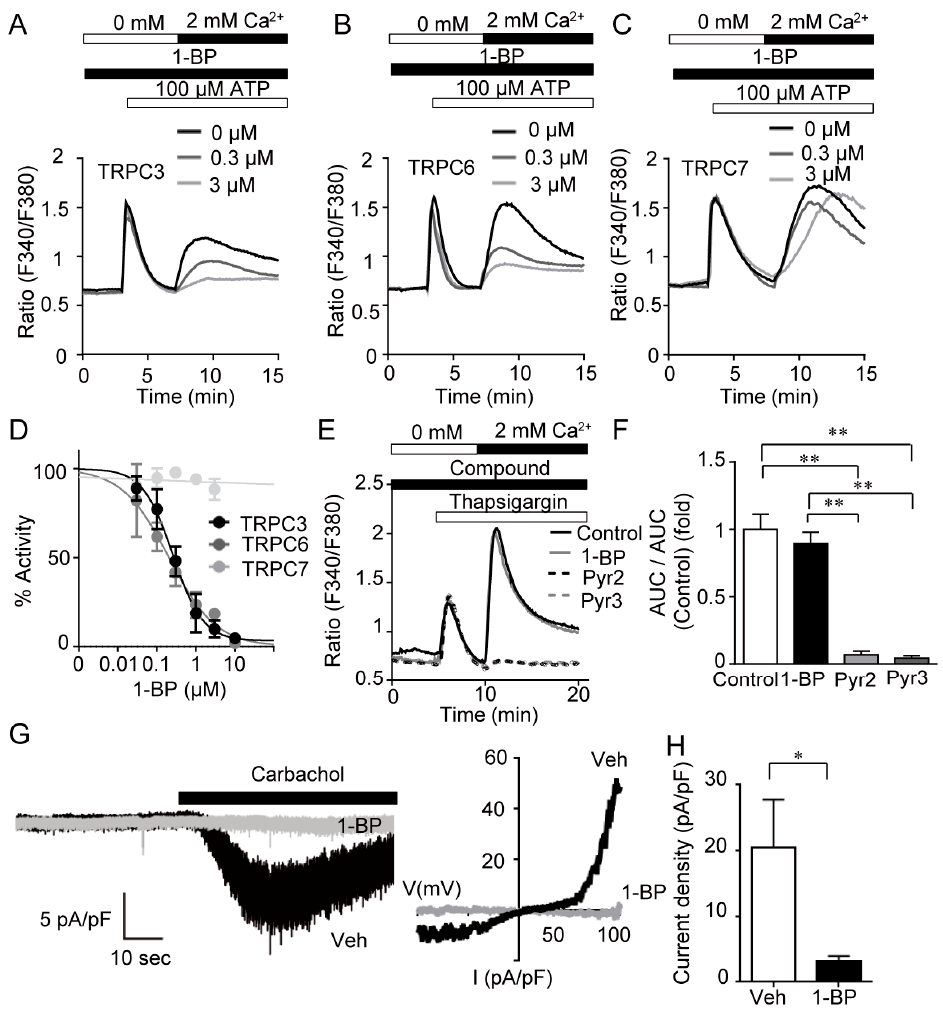
Figure 4. 1-BP selectively suppresses TRPC3/6-mediated Ca 2+ entry. ( A – C ) Average time courses of Ca 2+ responses induced by ATP (100 µM) in HEK293 cells expressing TRPC3 ( A ), TRPC6 ( B ), and TRPC7 ( C ) (n = 3 experiments). ( D ) Concentration-dependent inhibition of 1-BP on Ca 2+ influx-dependent [Ca 2+ ] i increases through TRPC channels (n = 3 experiments). ( E ) Average time courses of Ca 2+ responses induced